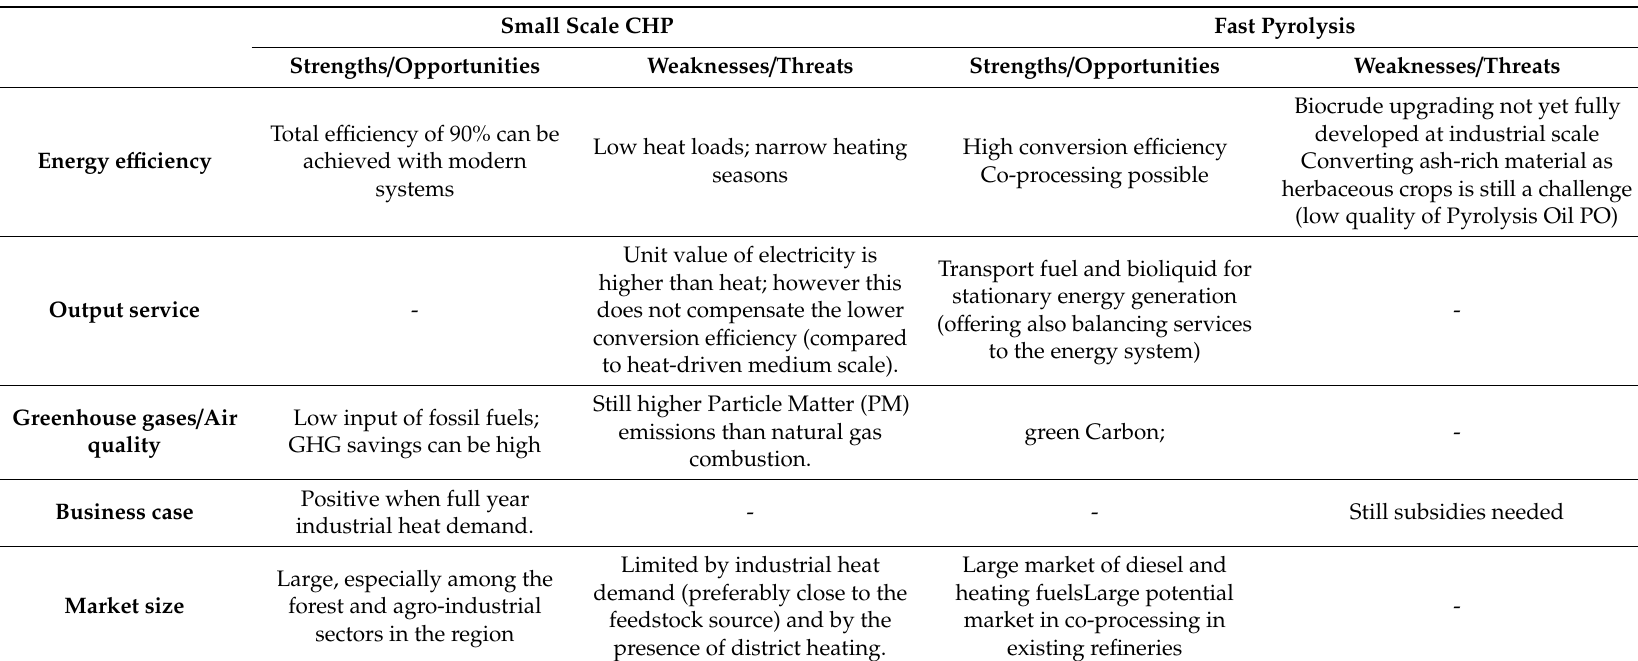
Table 2. Value chain related SWOT for resource e ffi